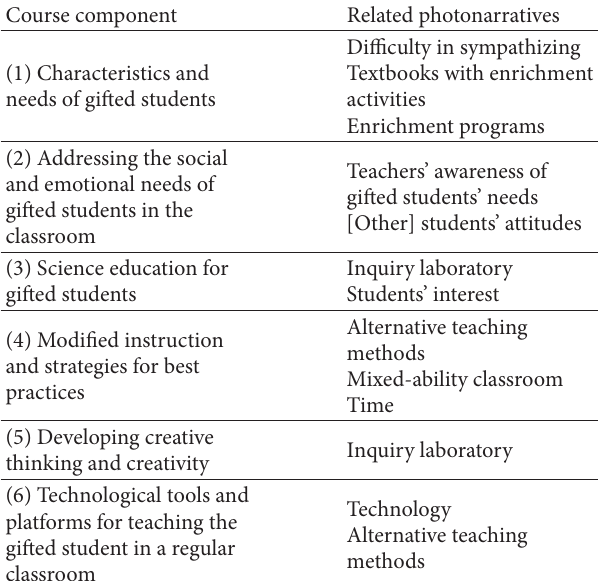
Table 1: Connections between teachers’ photonarratives and the PD course’s components according to teachers’ written